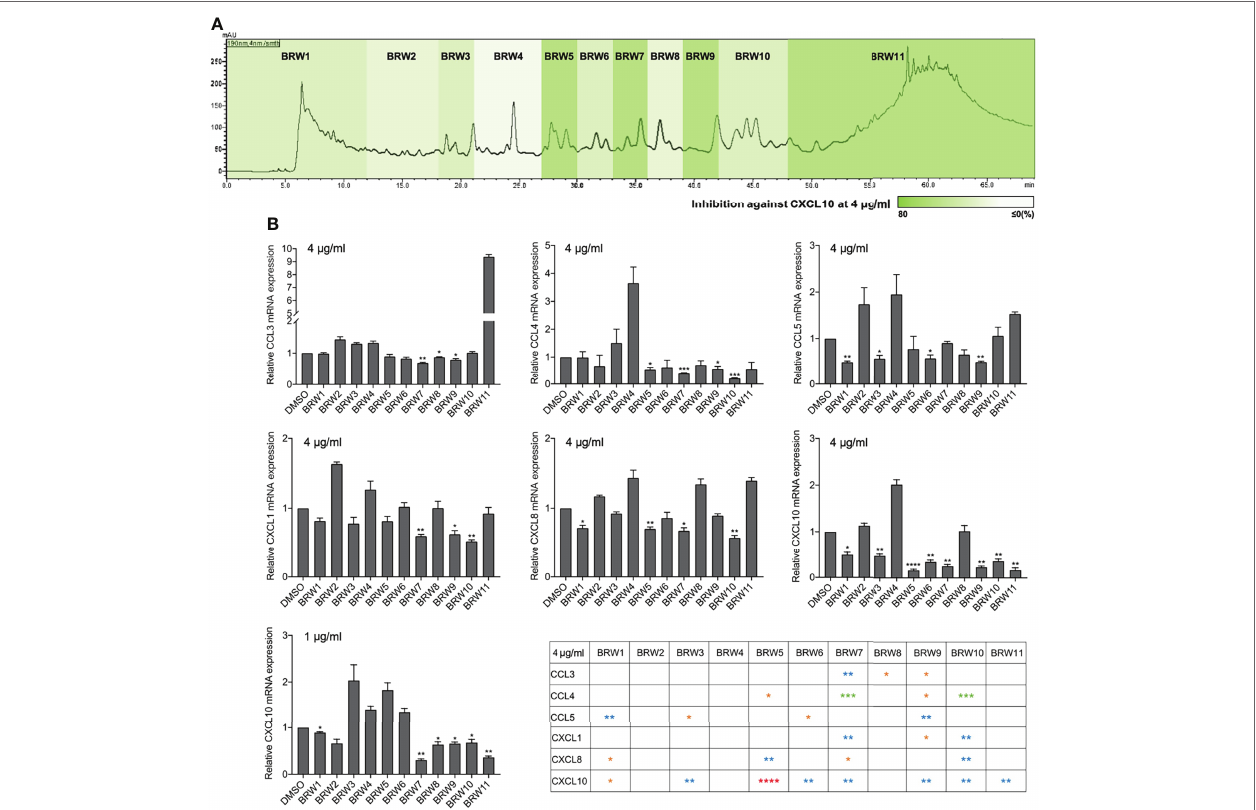
FIGURE 2 | The anti-neurofibroma assessment of the Lendenfeldia sp. sponge extract. (A) The high-performance liquid chromatography (HPLC) bioassay profiling was performed using the retention time-based fractionation approach together with (B) the assessment of chemokine inhibition (1 and 4 μg/ml) in neurofibroma cells CRL-3390. Results are presented as mean ± S.E.M. (n = 3). * p < 0.05, ** p < 0.01, *** p < 0.001, **** p < 0.0001 compared with the control (DMSO) on the reduction